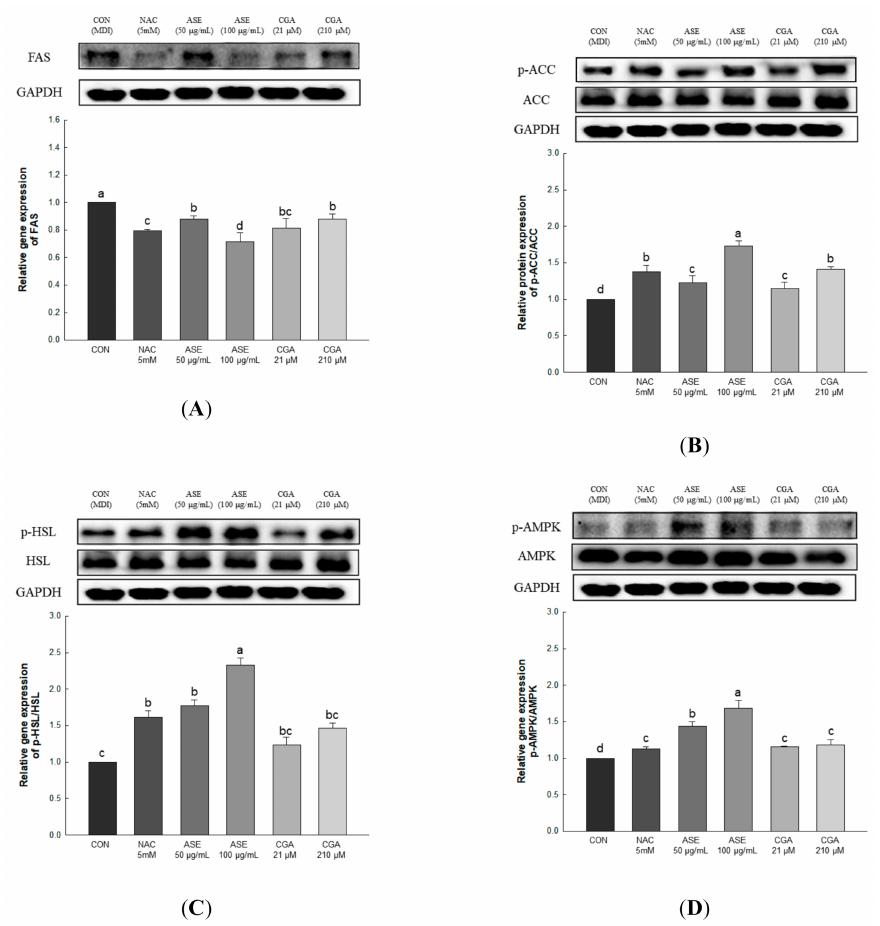
Figure 9. E ff ects of ASE and CGA on the expression level of AMP-activated protein kinase (AMPK) activation and lipid metabolism-related enzymes in 3T3-L1 adipocyte. Protein expression of FAS ( A ), p-ACC / ACC ( B ), p-HSL / HSL ( C ) and p-AMPK / AMPK ( D ). 3T3-L1 adipocytes di ff erentiated for 6 days were treated with ASE (50 and 100 µ g / mL) and CGA (21 and 210 µ M). Protein expression was quantified through western blotting and normalized through GAPDH expression level. Each value is expressed as the mean ± SD of triple determination. The other letters on the bars indicate a significant di ff erence of p < 0.05 in the Duncan multi-range test. a, b, c, d , and bc significant di ff erences among various parts of